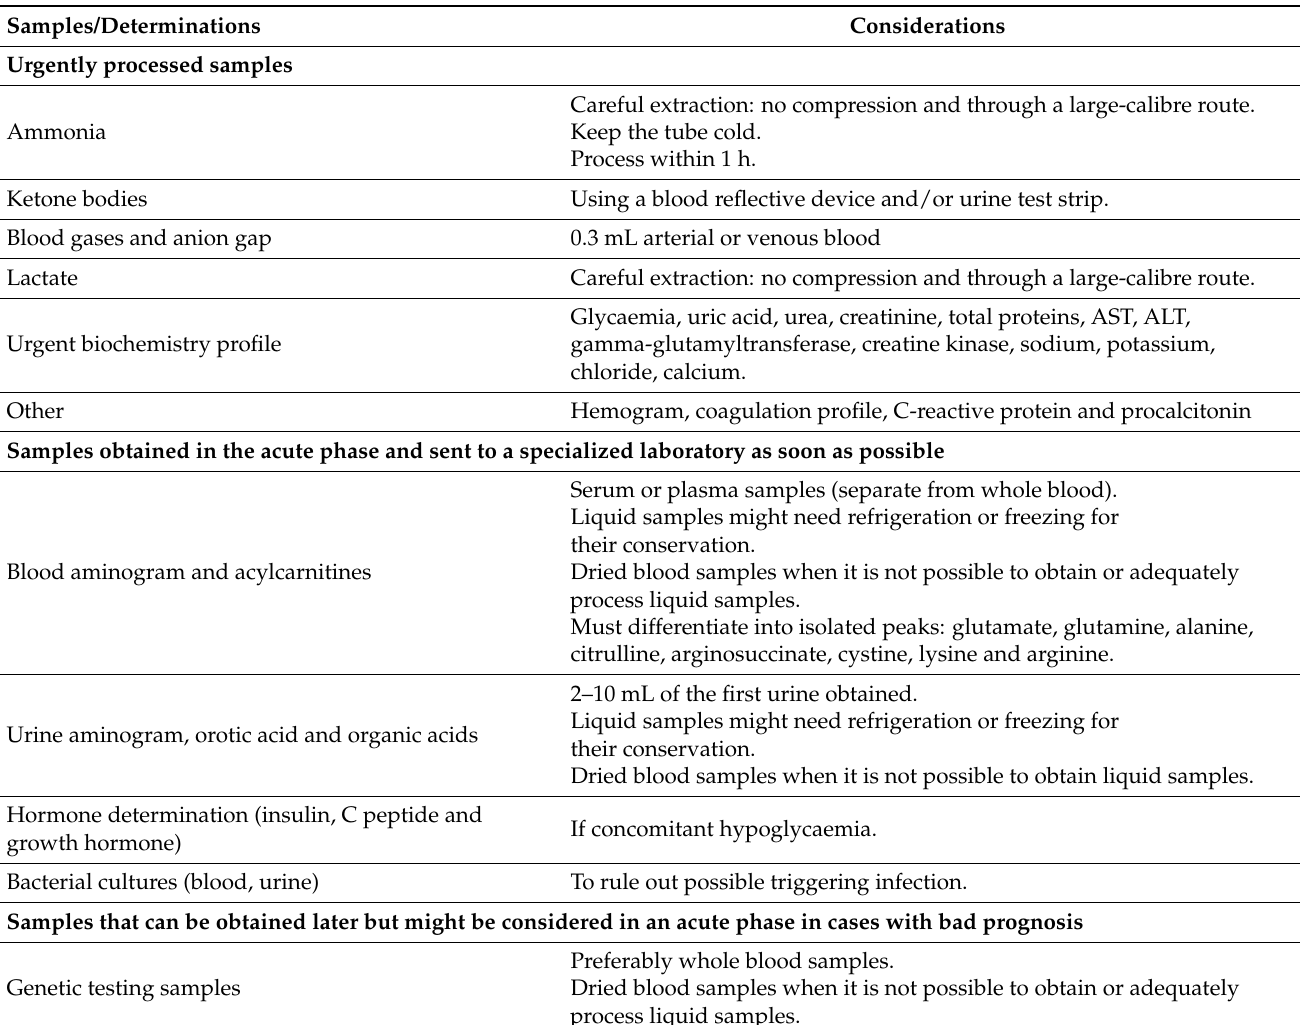
Table 2. Analytical determinations necessary for diagnosis in patients with